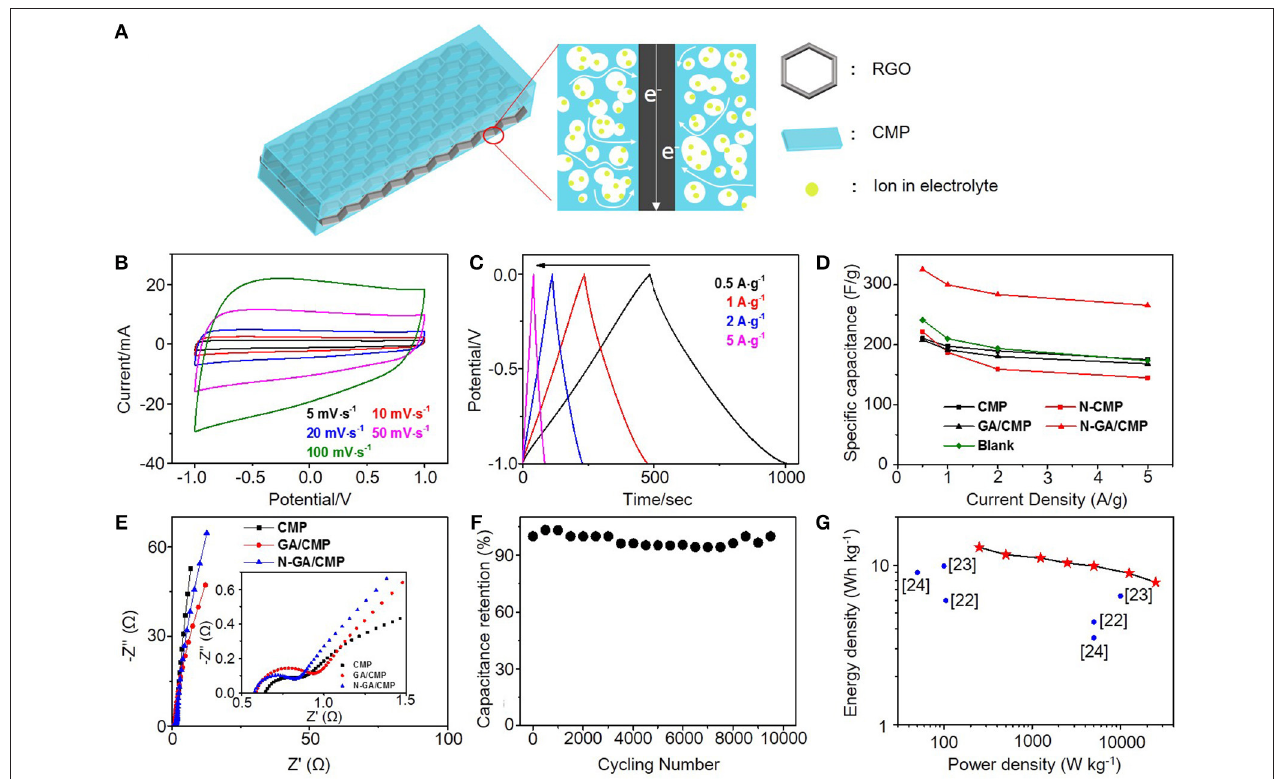
FIGURE 3 | (A) Illustration of the charge transfer in an N-GA/CMPs electrode. (B) CV curves and (C) GCD curves of the N-GA/CMPs. (D) Specific capacitances of CMPs, N-CMPs, GA/CMPs, N-GA/CMPs, GA and physical mixture of 85% CMP and 15% GA as blank. (E) Nyquist plots of the CMPs, GA/CMPs and N-GA/CMPs. The insert shows the plots in the high-frequency region. (F) Cycling performance of the N-GA/CMPs based supercapacitor. (G) Ragone plots of the N-GA/CMPs based two-electrode supercapacitor. The values reported by literatures are shown in the